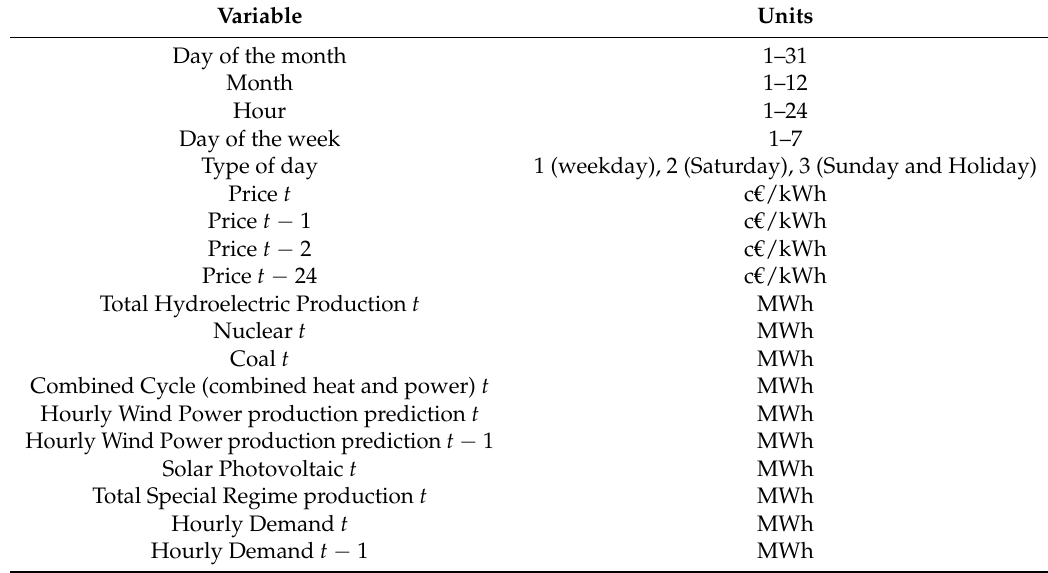
Table 1. All the variables used to forecast the electricity